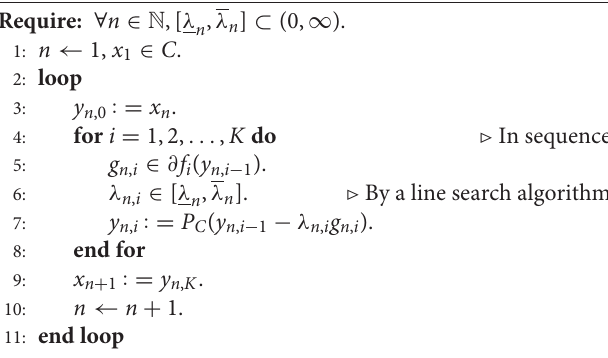
Algorithm 1: Incremental subgradient algorithm